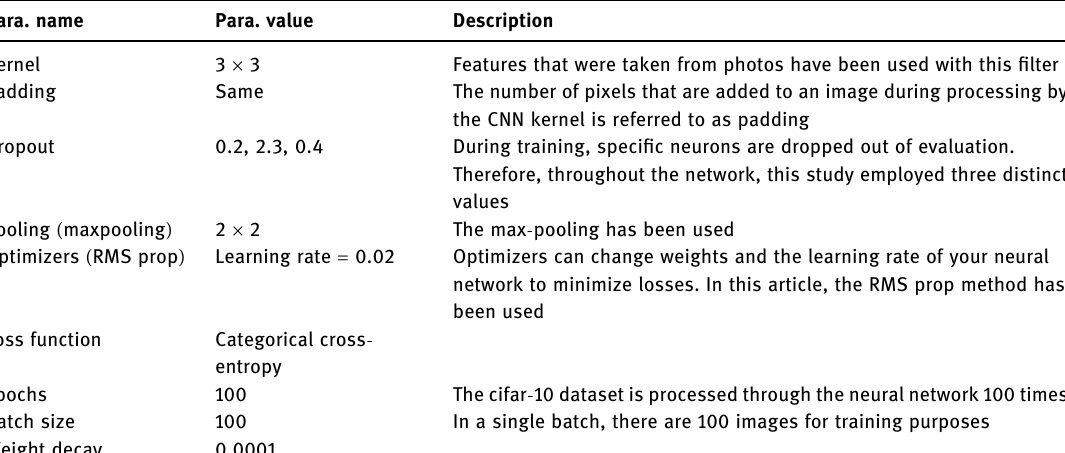
Table 1: Parameters in CNN algorithm Para. name